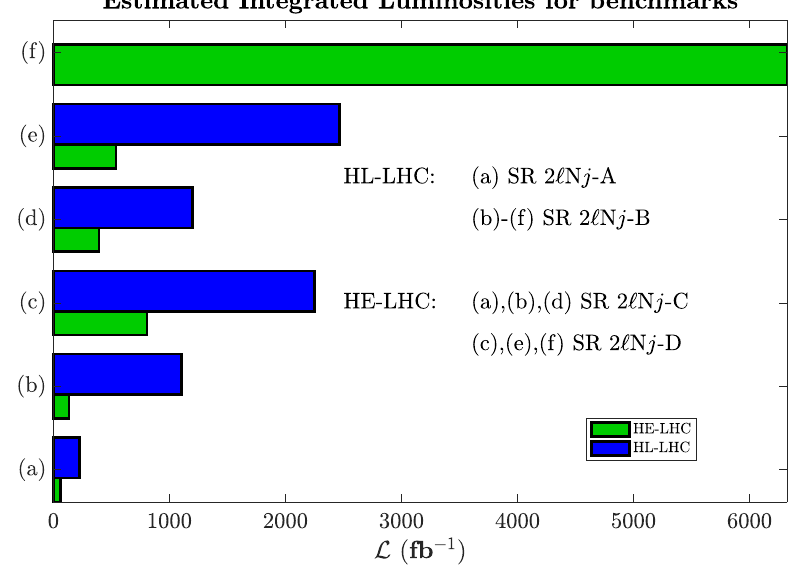
JHEP01(2021)047